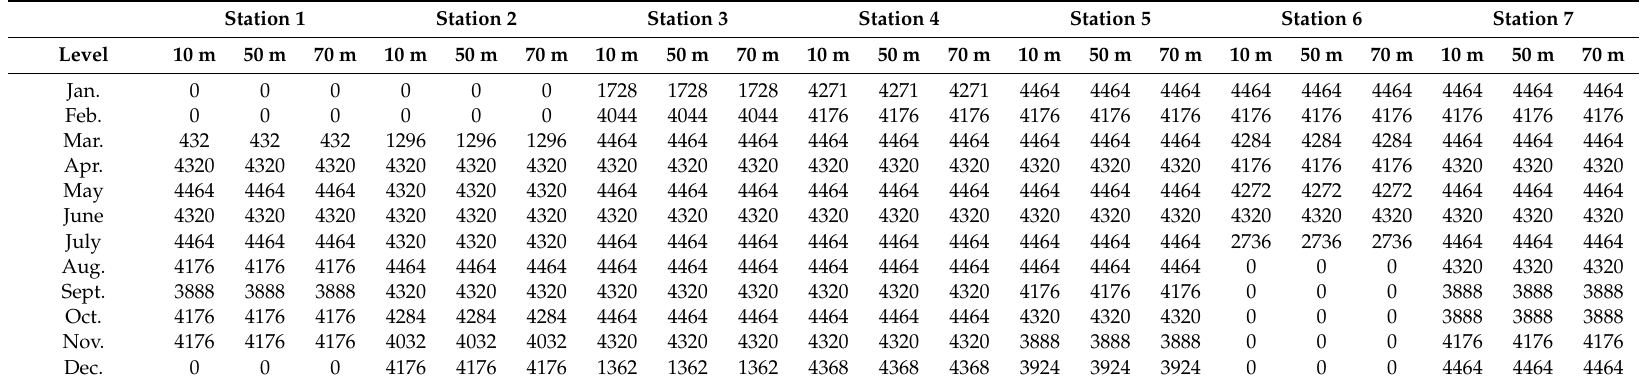
Table 3. The number of wind speed observations’ original data in di ff erent months of the year 2012. Each tower has height levels of 10, 50, and 70 m.